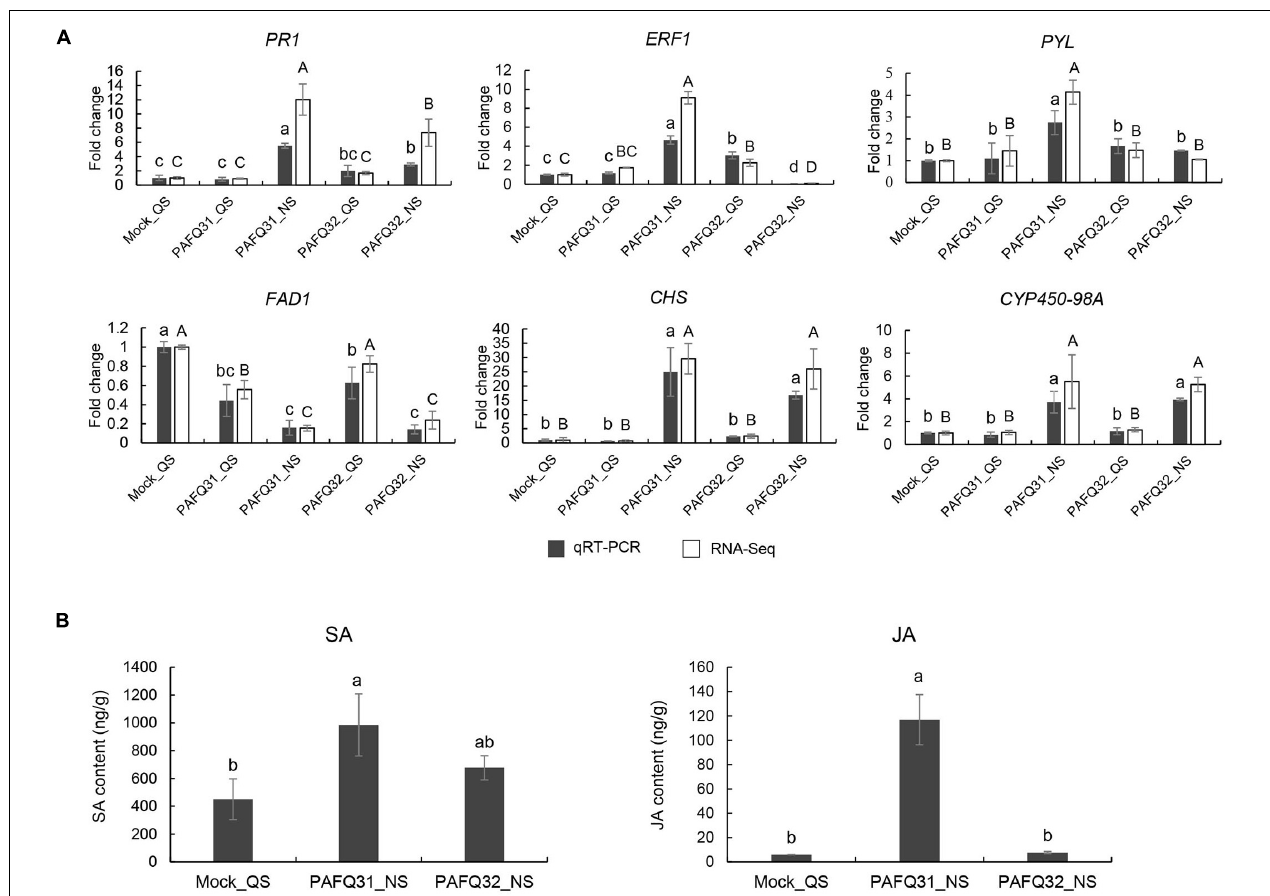
FIGURE 8 | Validation of RNA-Sequencing (RNA-Seq) data by quantitative real-time -PCR (qRT-PCR) and phytohormone production measurements. (A) qRT-PCR was conducted with beta-adaptin-like gene A ( BETAA-AD ) as an internal reference gene based on six DEGs, including pathogenesis-related protein 1-like ( Pp-PR1 ), ethylene-responsive transcription factor 1B-like ( Pp-ERF1 ), abscisic acid receptor PYL4-like ( Pp-PYL ), delta(8)-fatty-acid desaturase 1-like ( Pp-FAD1 ), chalcone synthase ( Pp-CHS ), and cytochrome P450 98A2-like ( Pp-CYP450-98A ). Error bars represent the standard deviations of the mean. Different letters over the error bars indicate the significant difference at the P = 0.05 level. The results of significance analysis for RNA-Seq data and qRT-PCR data are showed by (A–C) and (a–c) , respectively. (B) The levels of SA and JA in P. pyrifolia infected by strains PAFQ31 and PAFQ32 at NS, respectively. Error bars represent the standard deviations of the mean. Different letters over the error bars indicate the significant difference at the P = 0.05